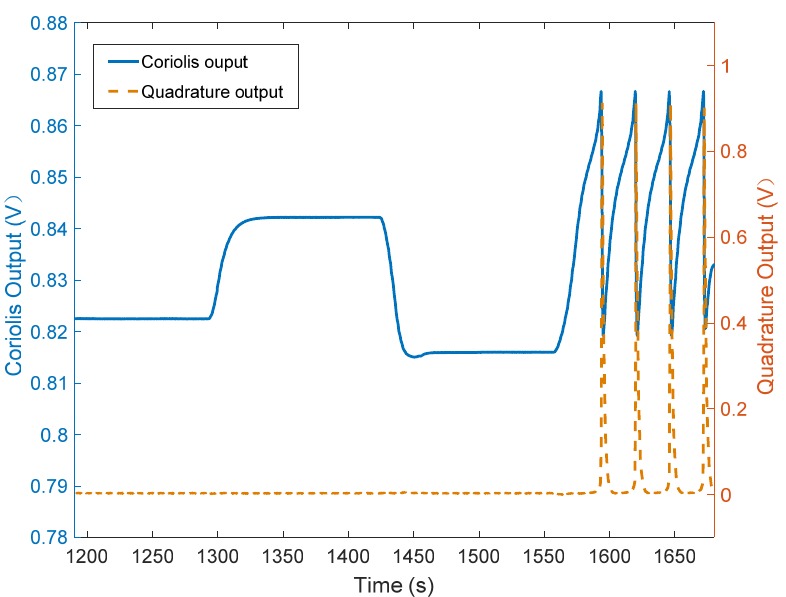
Figure 10. The Coriolis output signal becoming unstable in the Scenario C imitated experiment. Table 1. The experimental results of the electric malfunction imitated test.